Question: Identify the chart type used in this figure.
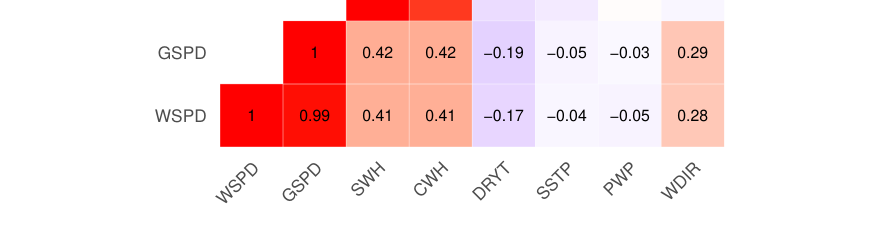
Answer: heatmap